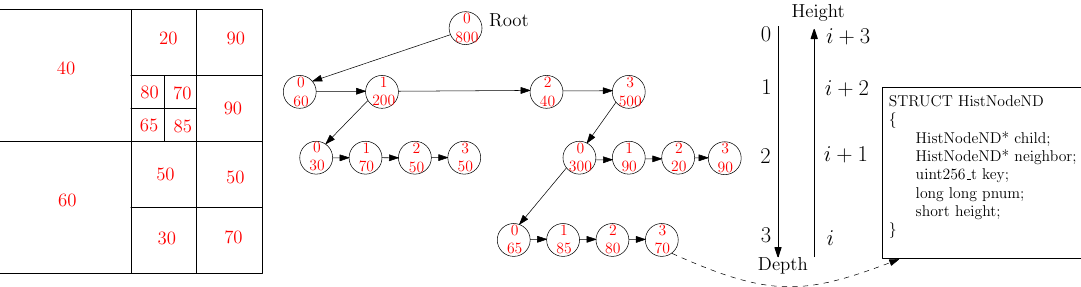
Figure 3. A 2D HistTree example, where the threshold is 100; left: point counting, middle: pointer structure of HistTree, with each node storing a SFC key and number of points, right: structure of a HistTree